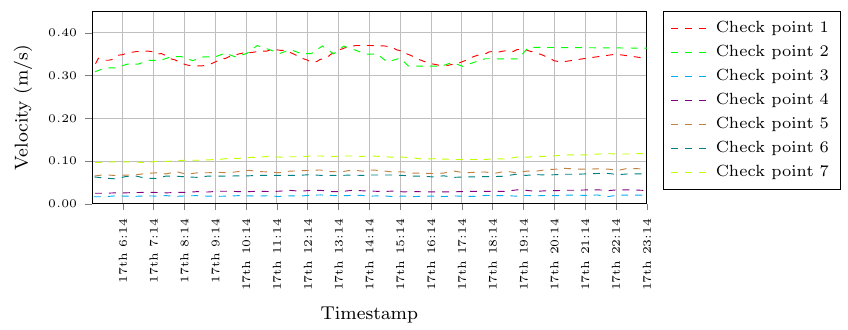
Figure 8. Velocity time series graphs (June